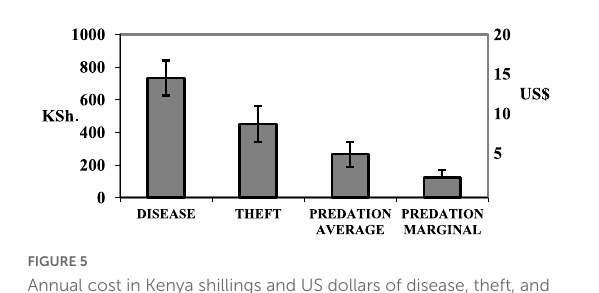
FIGURE5 Annual cost in Kenya shillings and US dollars of disease, theft, and predation (+ SE) per head of cattle on twenty Laikipia commercial ranches in 1995–1996 ( F = 8.75; df = 3.76; p = 0.00005).